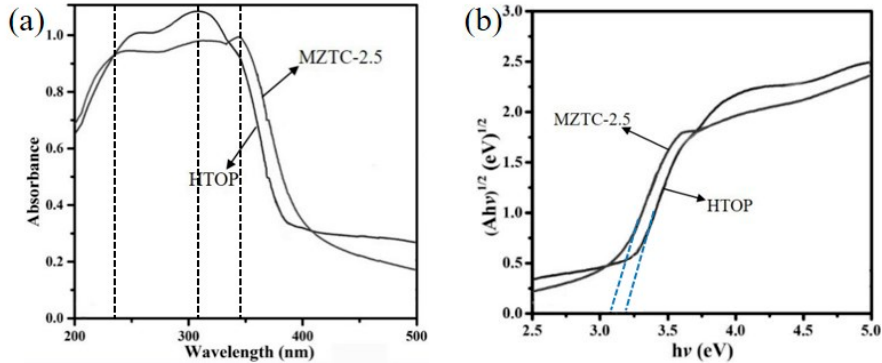
Figure 6. ( a ) UV–vis diffuse reflectance spectra; ( b ) Kubelka–Munk (Ah ν ) 1/2 versus energy.